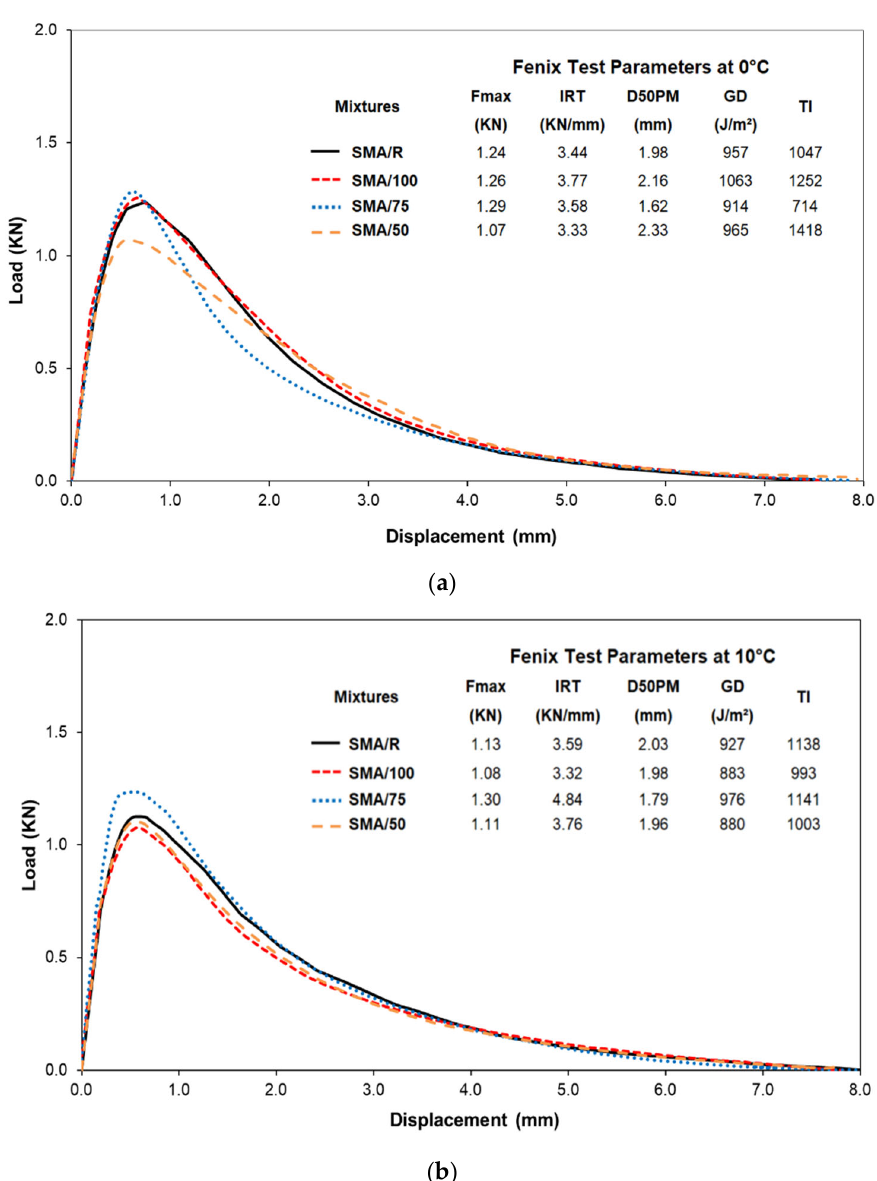
Figure 9. Fénix test parameters at different temperatures: ( a ) 0 °C; ( b ) 10 °C. Figure 9. F é nix test parameters at different temperatures: ( a ) 0 ◦ C; ( b ) 10 ◦